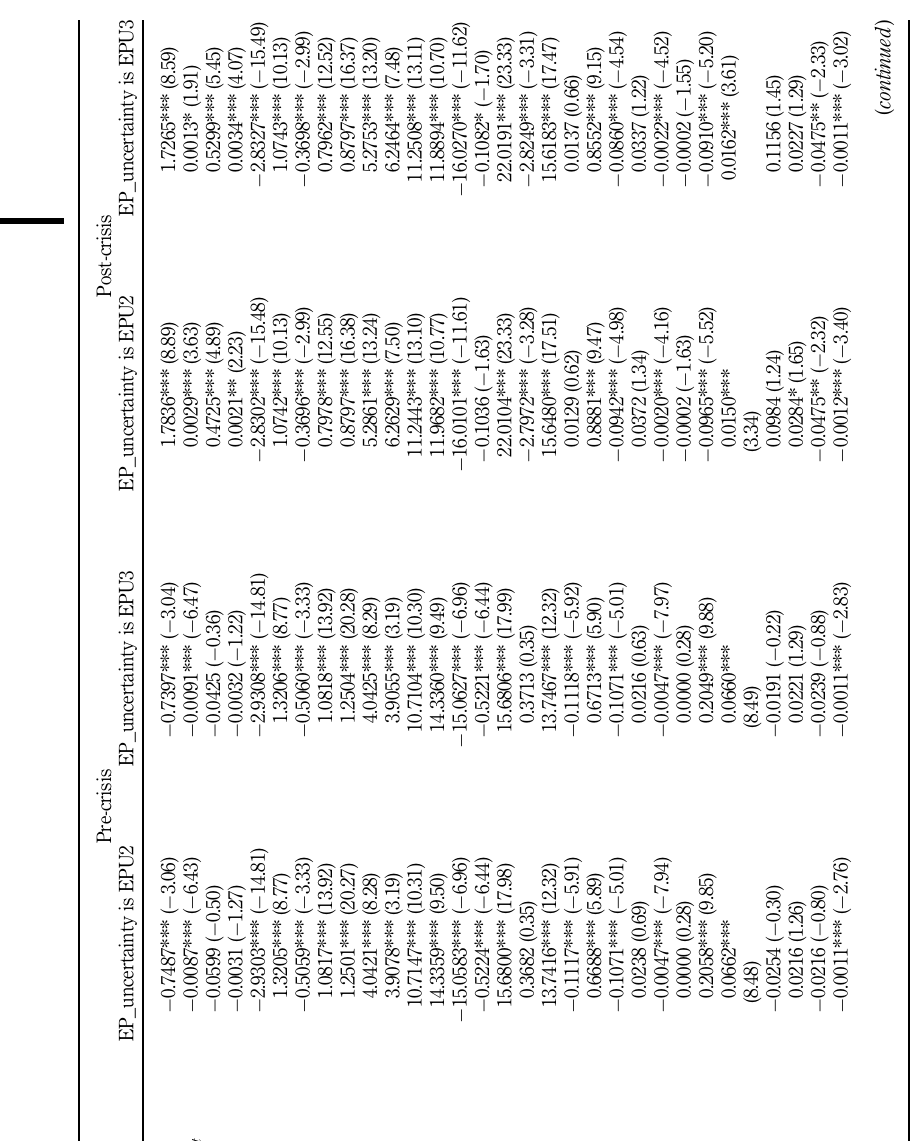
Table 5. Robustness checks with alternative measures of economic policy